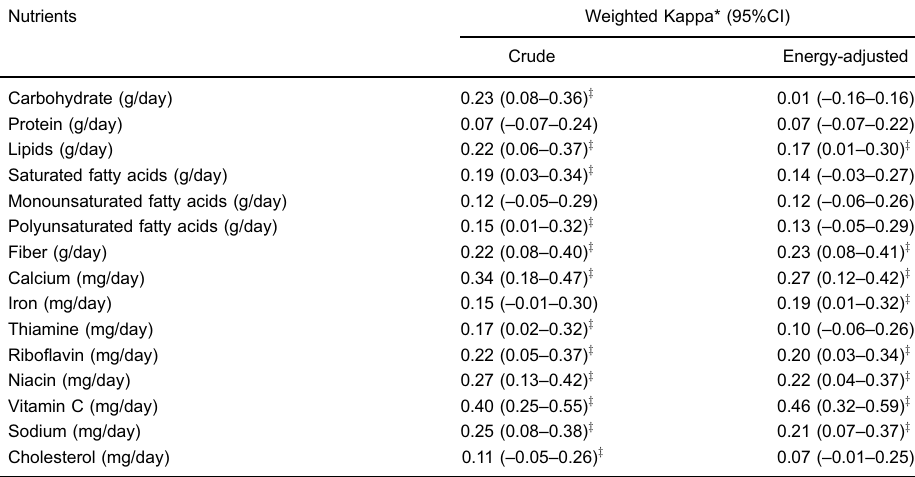
Table 4. Crude and adjusted weighted kappa of nutrient intake measured with the 24-hour recalls and the food frequency questionnaire.